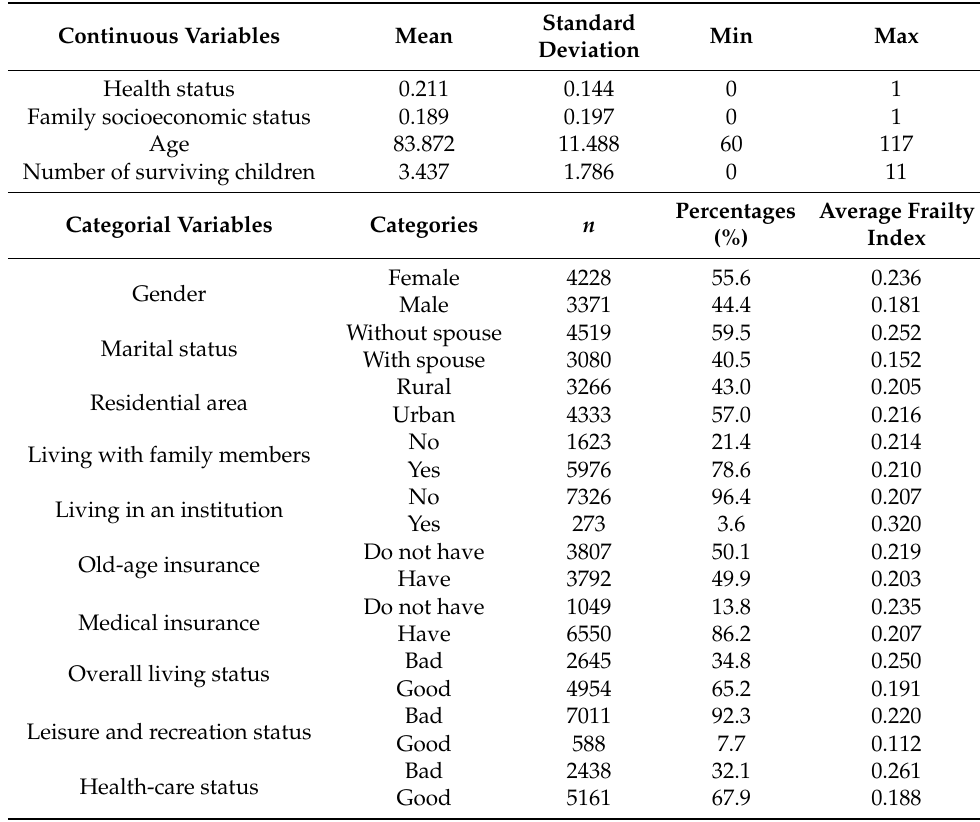
Table 1. Variables and data